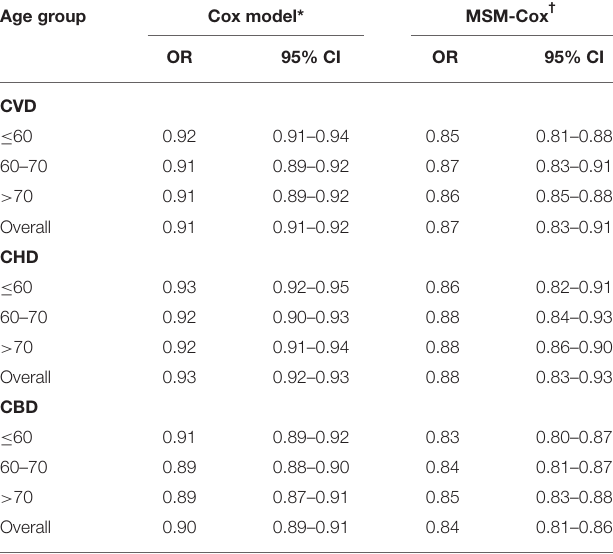
TABLE 3 | Multivariable associations of outcomes with LTPA increase of 60 min/week estimated by MSM-Cox and Cox model.